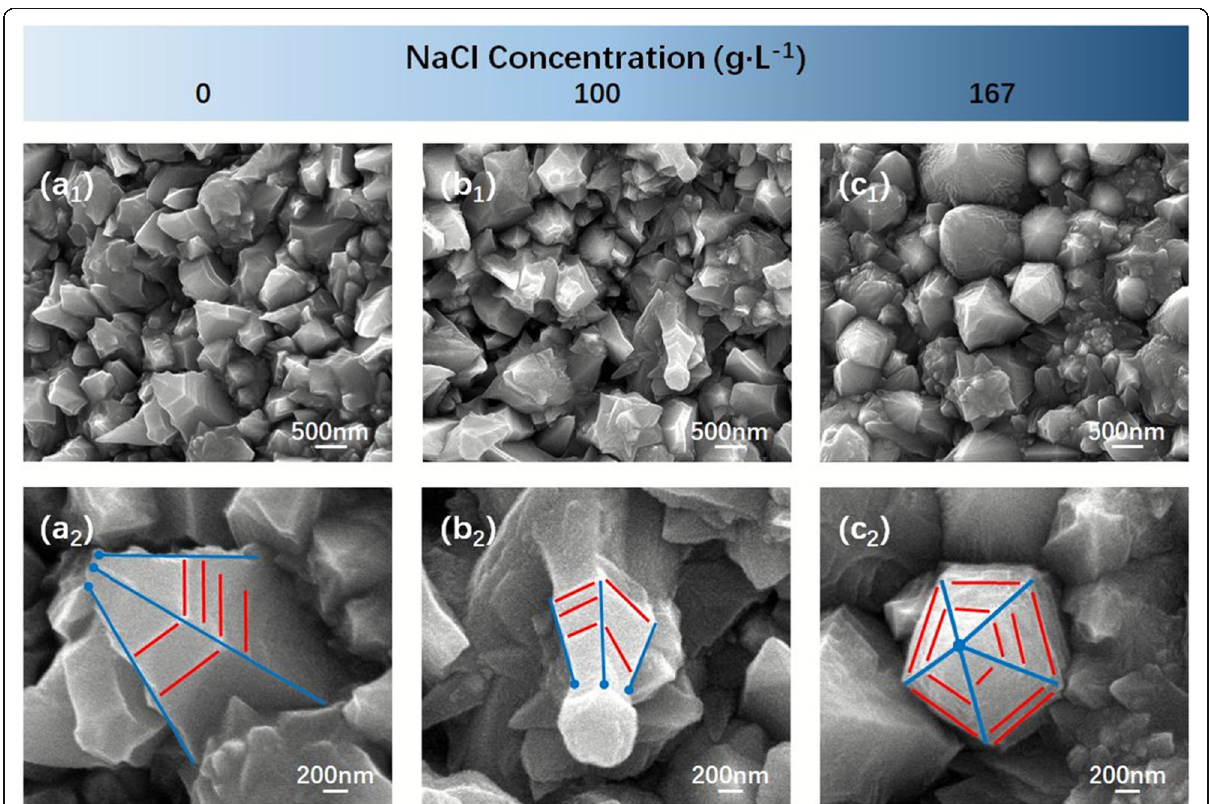
Fig. 4 Low- and high-magnification SEM images of cathode that electrodeposited at different NaCl concentrations: 0 g/L ( a 1 , a 2 ), 100 g/L ( b 1 , b 2 ), and 167 g/L ( c 1 , c 2 ),